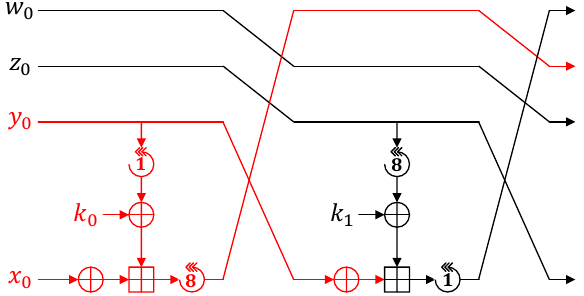
Figure 15. Rounds that can be efficiently progressed by a fixed nonce in CHAM.